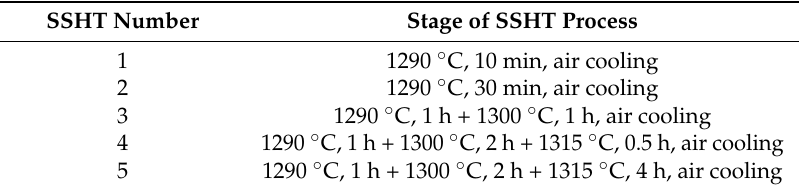
Table 2. Standard solution heat treatment (SSHT) number applied in presented investigation. SSHT Number Stage of SSHT